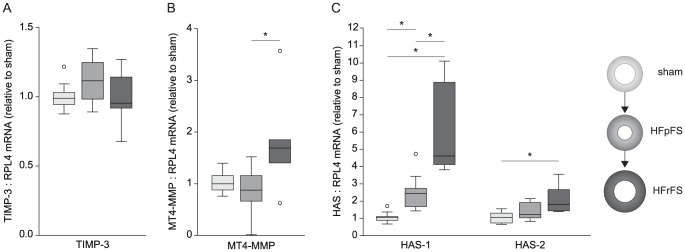
Myocardial TIMP-3, HAS and MT4-MMP mRNA levels in rats after aortic banding.Myocardial mRNA expression of TIMP-3, HAS and MT4-MMP in rats with preserved (HFpFS, n = 9) or reduced FS (HFrFS, n = 6) six weeks after aortic banding, normalized to the reference gene ribosomal protein L4 (RPL4) and relative to sham (n = 9). Box-plots show median (horizontal line), interquartile range (box), 1.5xinterquartile range or maximum/minimum range (whiskers) and outliers (>1.5xinterquartile range). *p<0.05. AB, aortic banding; FS, fractional shortening; TIMP, tissue inhibitor metalloprotease; HAS, hyaluronic acid synthase; MT, membrane-type.